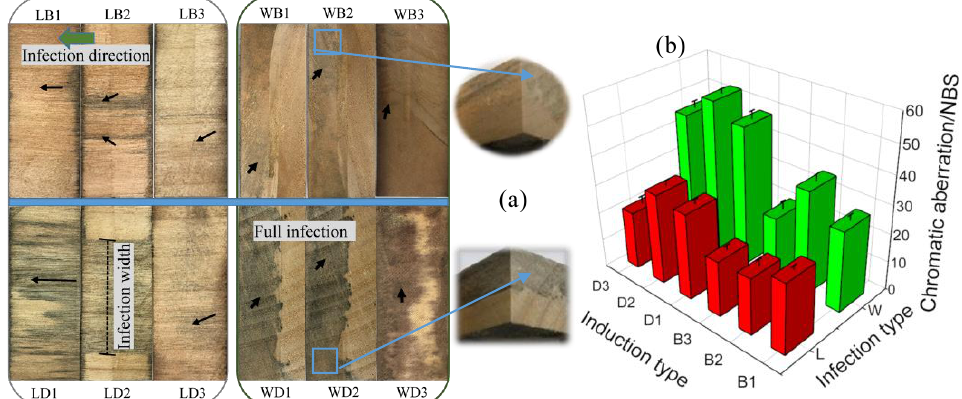
Figure 2. ( a ) Dyeing graph and ( b ) chromatic aberration of vertical and horizontal dyeing of poplar wood by Lasiodiplodia theobromae after 20 and 40 days. (LB1 stands for vertical infection–20 days–control group).